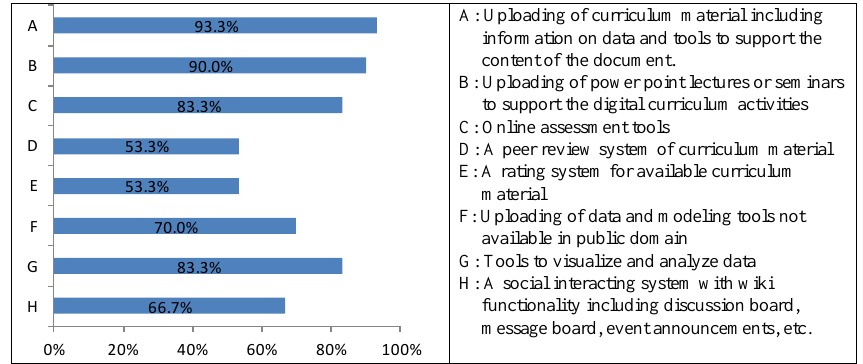
Figure 1: Percentages of workshop participant survey respondents (N = 37) rating specific Fig. 1. Percentages of workshop participant survey respondents ( N =37) rating specific learning community cyberinfrastructure capabilities learning community cyberinfrastructure capabilities and design criteria as important for their and design criteria as important for their personal personal applications.